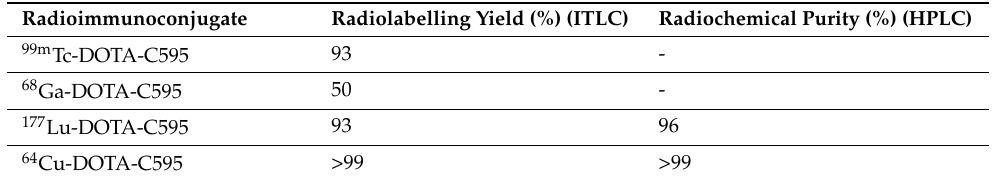
Figure 5. ELISA assay comparing the binding affinity of p-SCN-Bn-DOTA-C595 and unmodified C595 to MUC1 peptide at 405 nm absorbance. Table 3. Radiolabelling yield and radiochemical purity of radioimmunoconjugates.